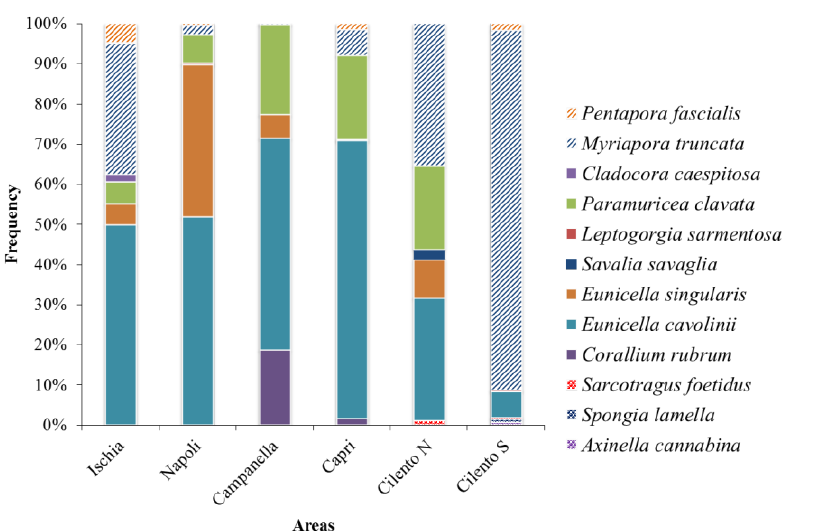
Figure 3. Species Dominance (Di = frequency of i-th species on the total of CSS) in each area.